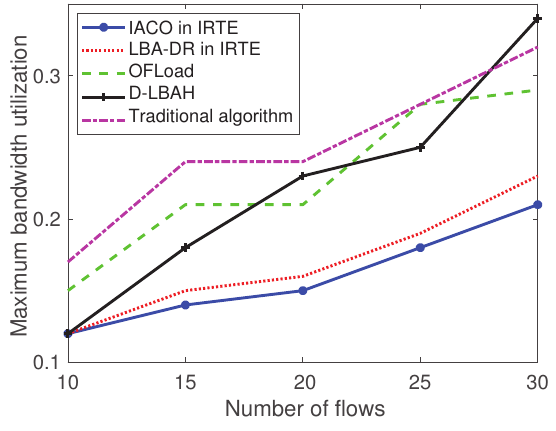
Fig. 5 Increasing flow number in Aconet.